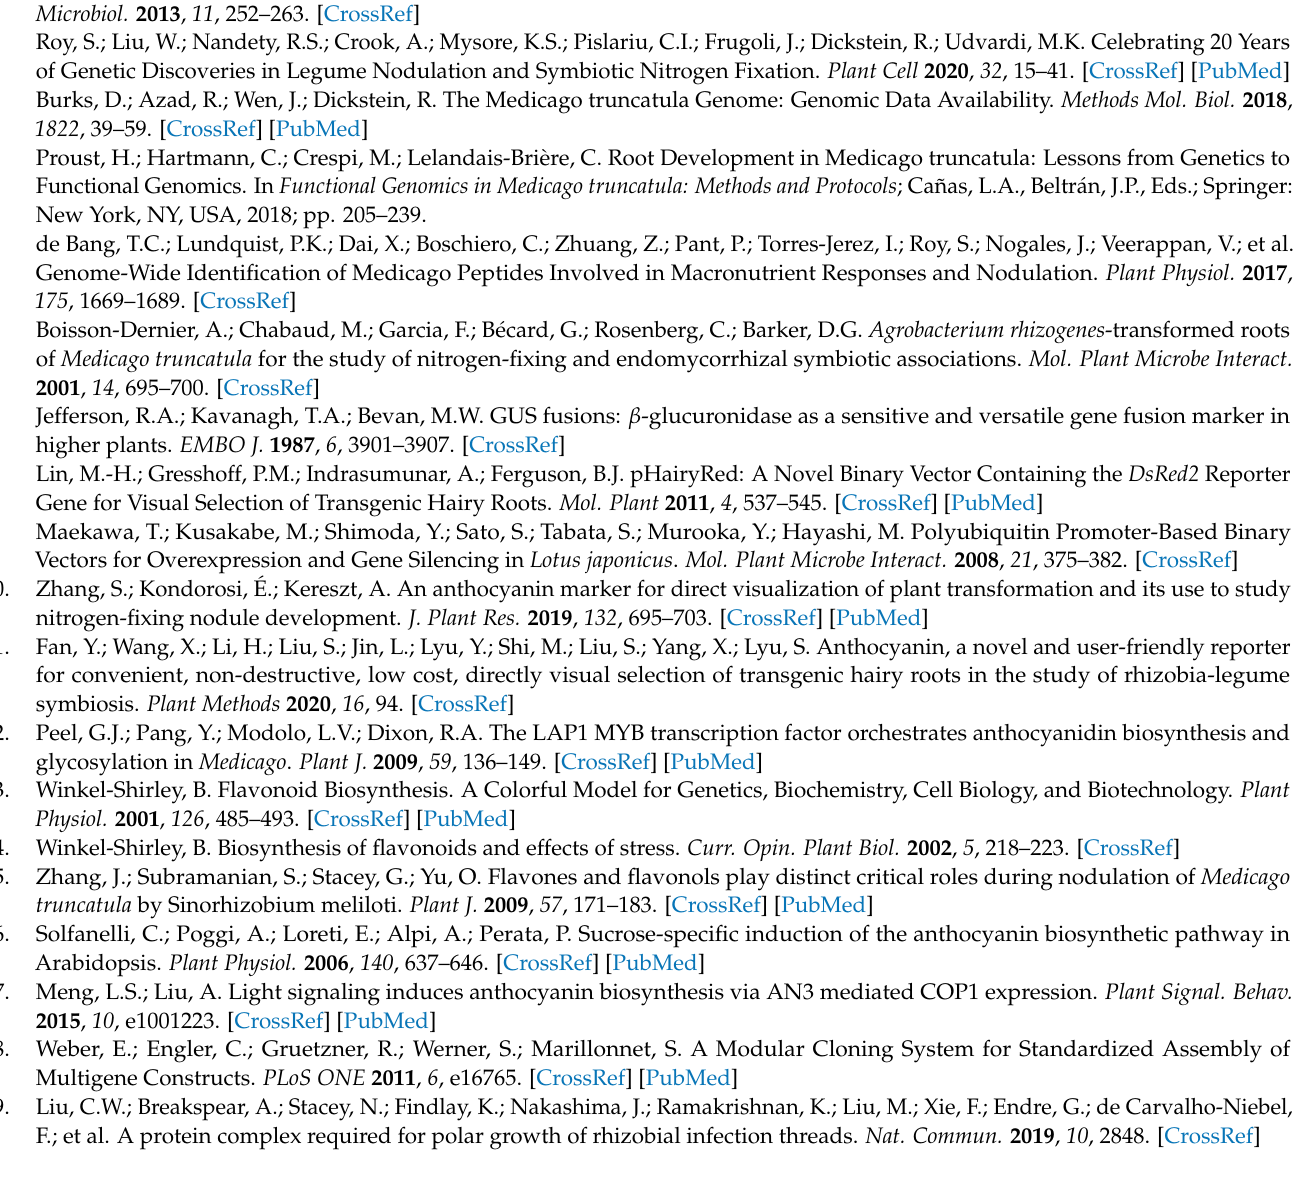
in vacuoles and red root tips in nodulated plants; Figure S3: MtLAP1 system in tomato hairy root transformation system; Figure S4: Sucrose and light treatments on A17 and R108 wild types; Figure S5: Sucrose and light treatments on A17 and R108 transgenic plants transferred with pAtUbi10-DsRed; Figure S6: MtRC gene expression atlas in different